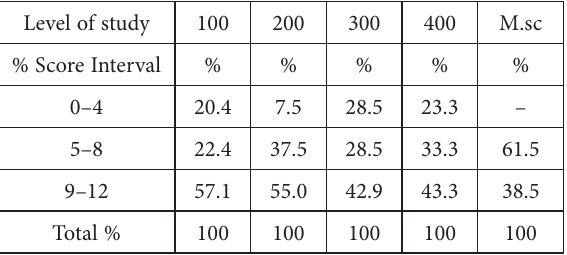
Table 4. Percentage distribution of score interval